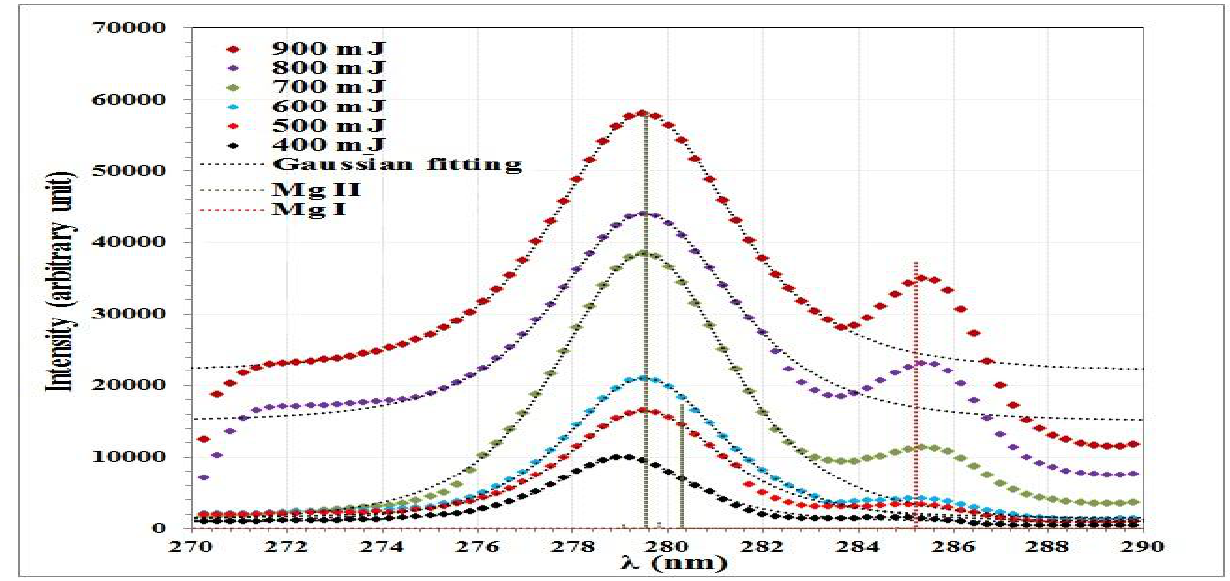
Fig.8: Variation in the signal intensity and width of the Mg (II) lines at 279.553 nm and Mg I 285.2 nm at different values of 1064 nm laser.